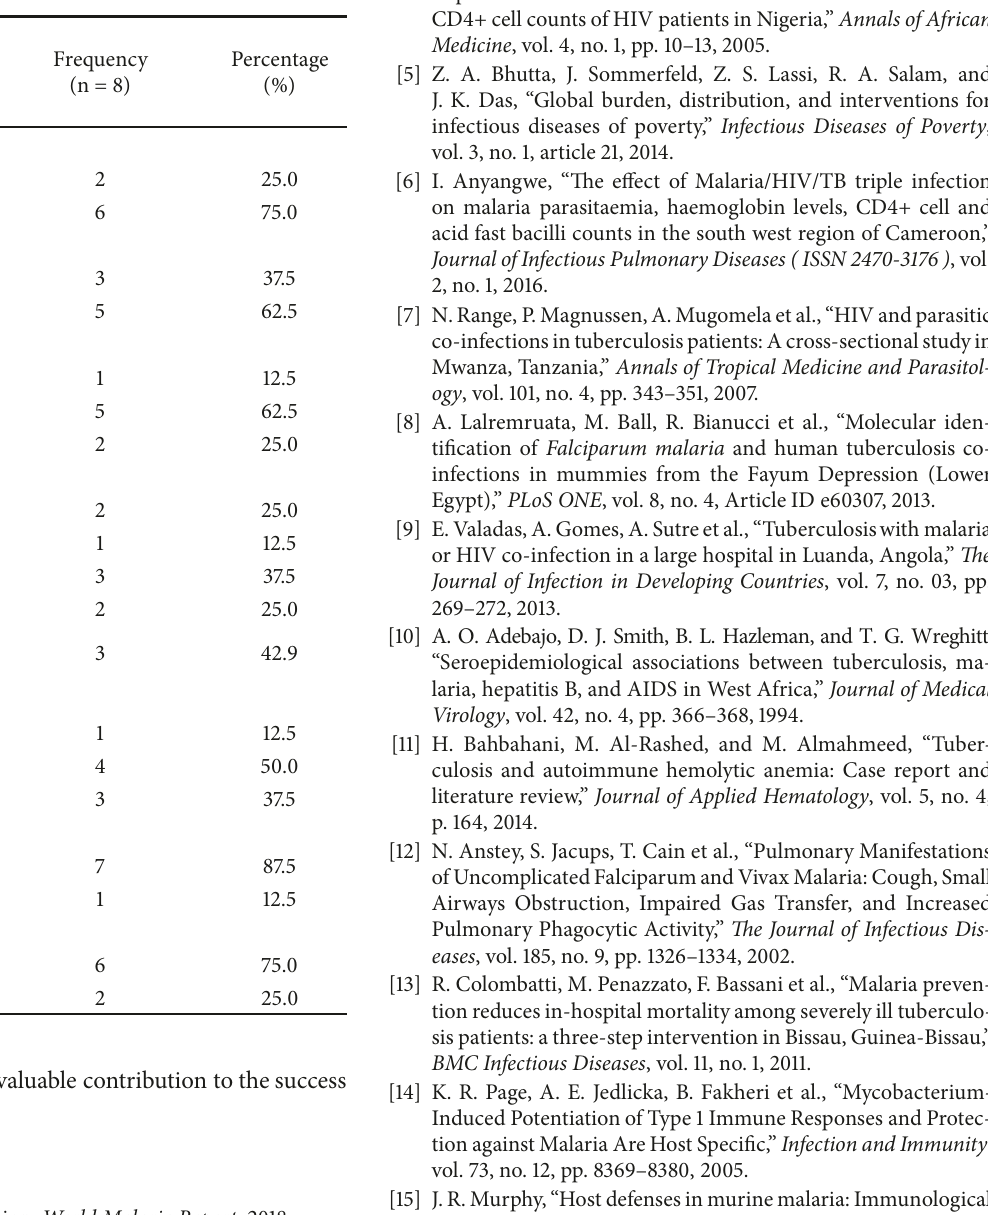
Table 4: Characteristics of participants with malaria/TB co-